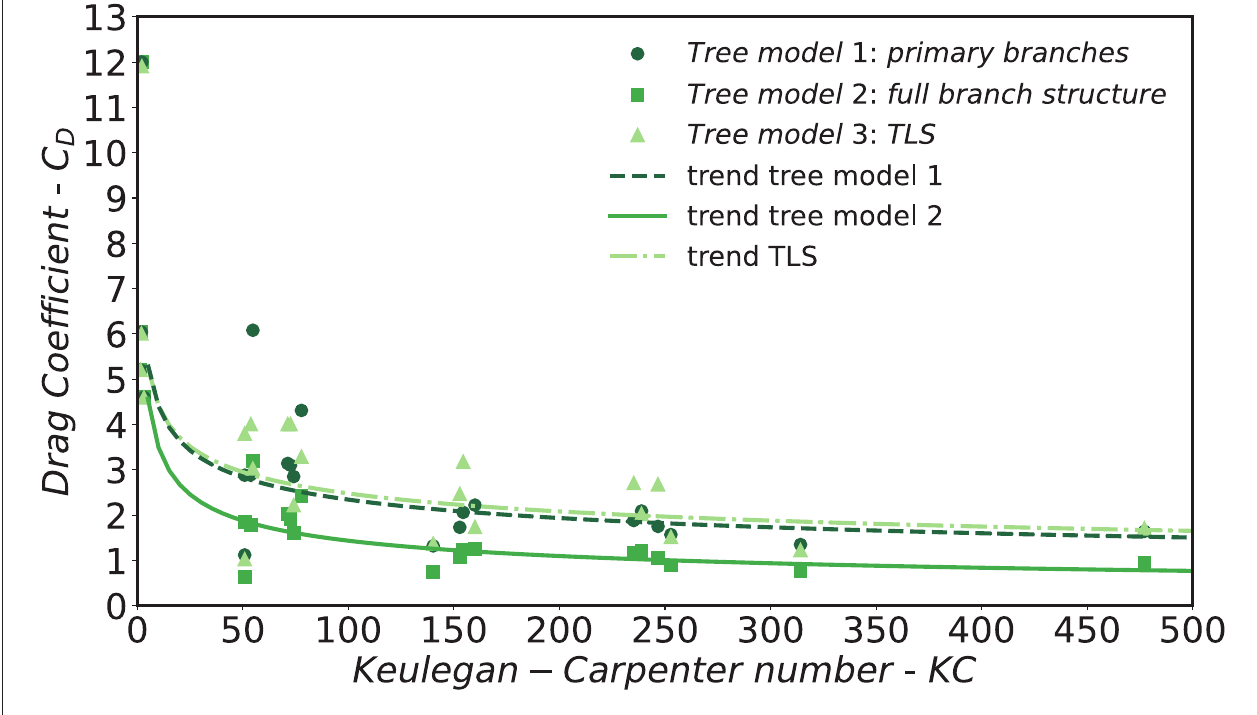
FIGURE 12 | Relation between C D and KC for tree model 1 (only the Primary branches), tree model 2 (primary branches including the side branches), and tree model 3 ( TLS